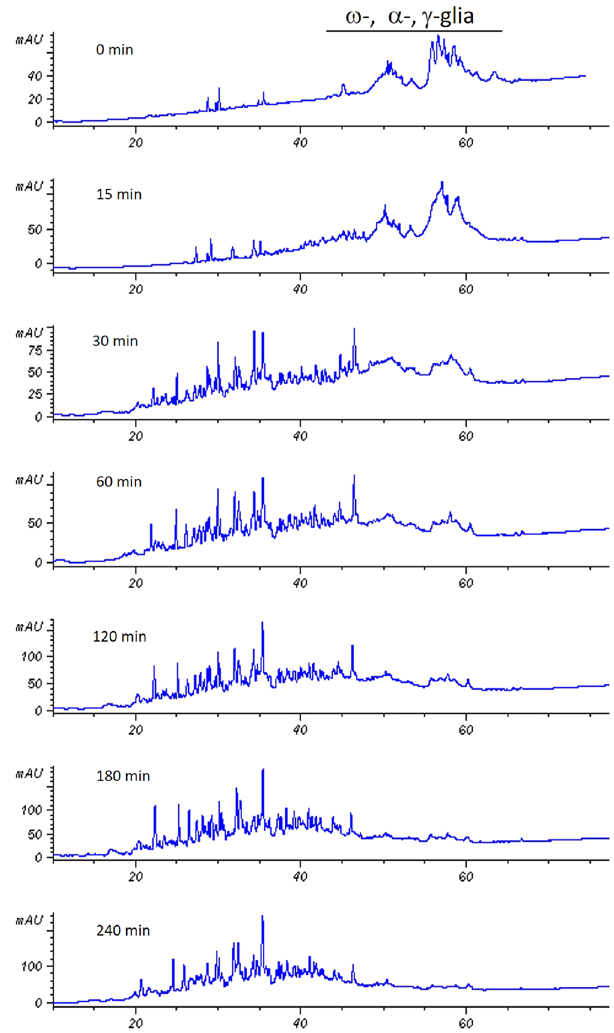
Figure 6. HPLC analysis of gliadin incubated with recombinant E40 at different incubation time, up to 240 min. At time point 0, gliadin proteins were fractionated according to the hydrophobicity in ω -, α -, and γ